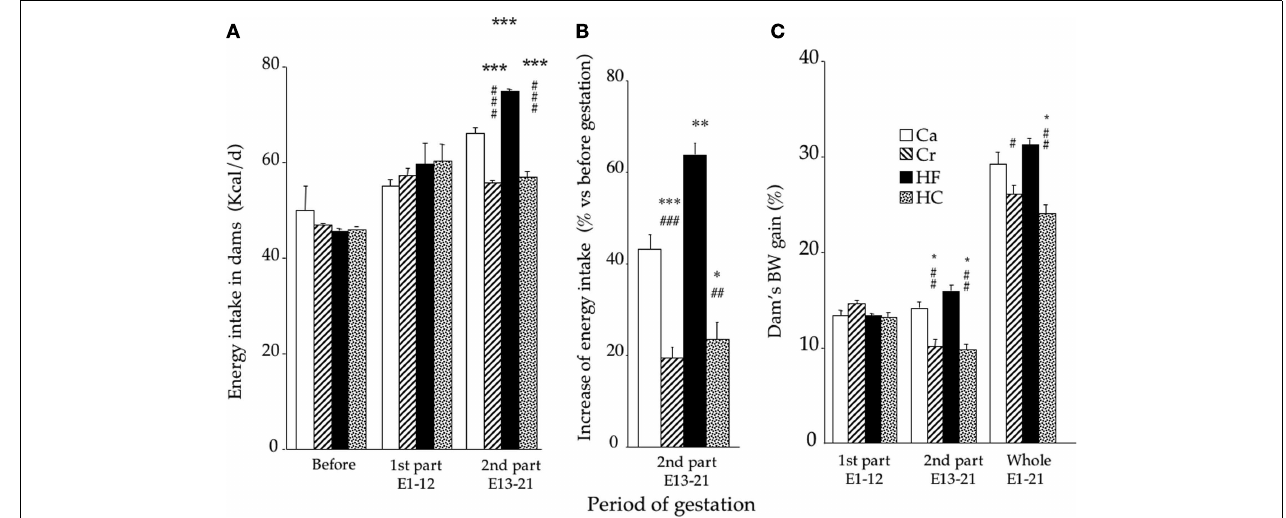
FIGURE 2 | Energy intake [(A); mean ± SEM in kcal/day) before, and during the first (day 1 to day 12) and second part (day 12 to day 21) of gestation (A), proportional increase in energy intake during the second part of gestation vs before gestation (B), and body weight